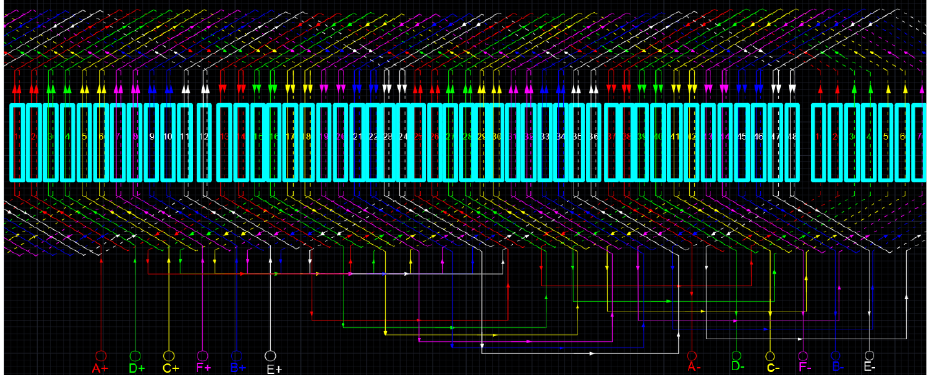
Figure 2. Motor winding design drawing.